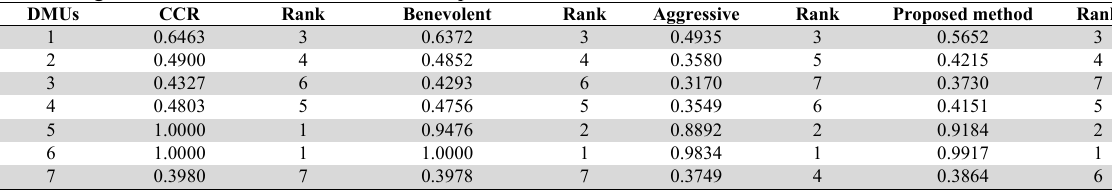
The ranking of DMUs for seven biomass fuel briquettes DMUs